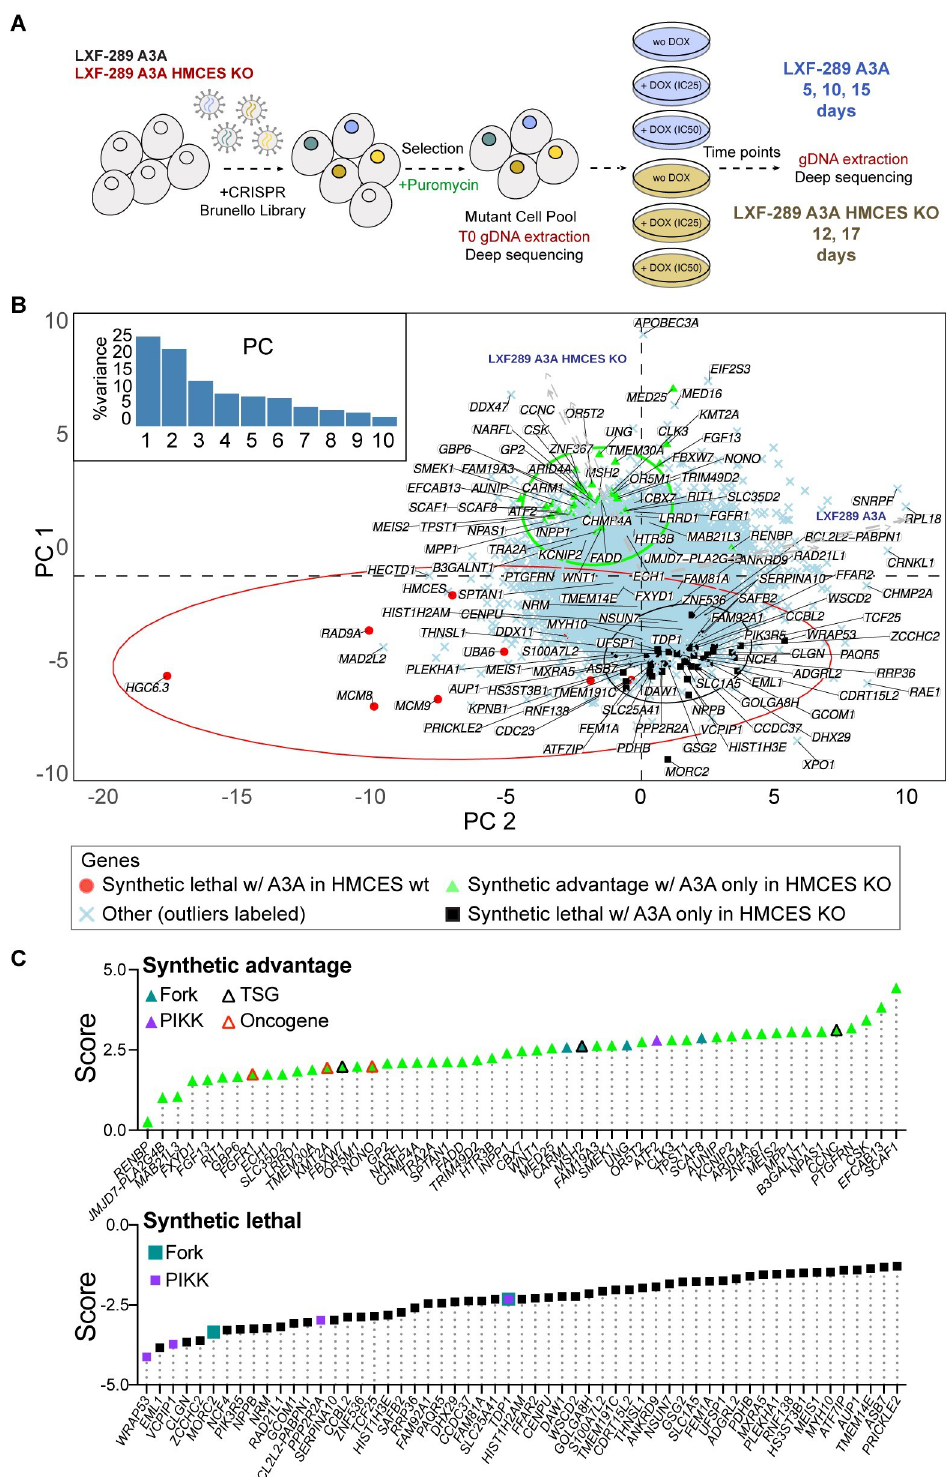
Fig 6. Secondary screening identifies modifiers of the response to A3A in HMCES KO LXF-289 cells. ( A ) Schematic of the secondary screen in LXF-289 A3A HMCES KO cells. ( B ) PC analysis of A3A conditional LFC scores for all genes across all 10 experimental conditions (see labels next to arrows, which show loadings of the conditions